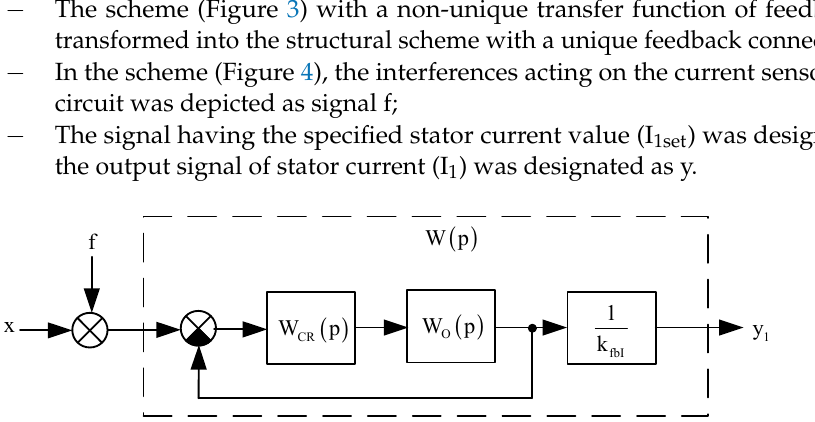
Figure 4. Design structural scheme of the current control channels.